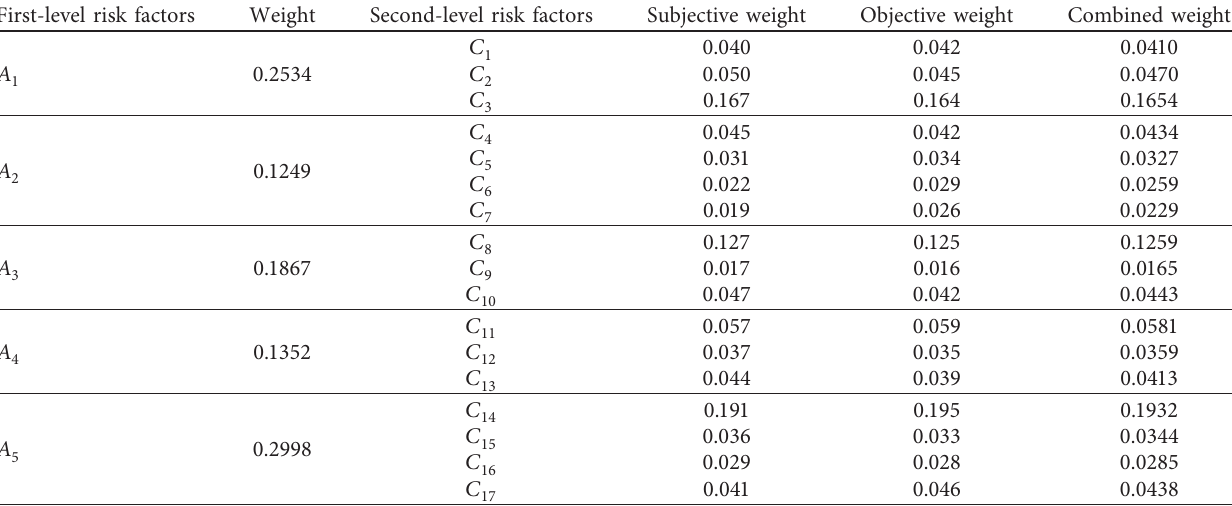
Table 6: Weights of first-level risks and second-level risks.